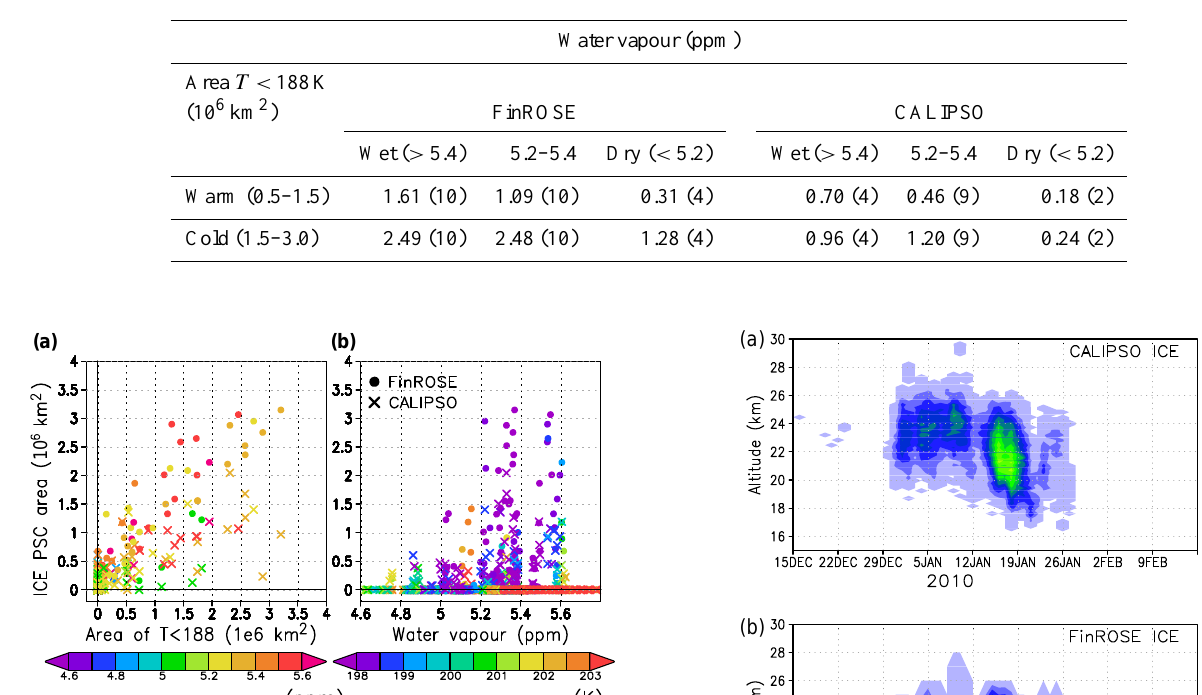
Table 2. Monthly mean ice PSC areas (10 6 km 2 ) in FinROSE (left) and CALIPSO (right) at 56hPa pressure level as a function of 56hPa monthly mean water vapour concentration (ppm) averaged north of 60 ◦ N and the area of temperatures below 188K (10 6 km 2 ). The number of months in each group is shown in parentheses.